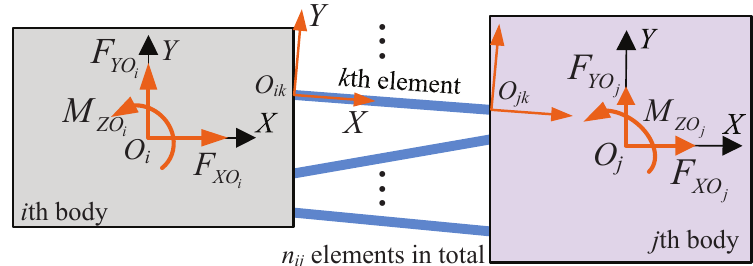
Figure 3. Two rigid bodies connected by beam